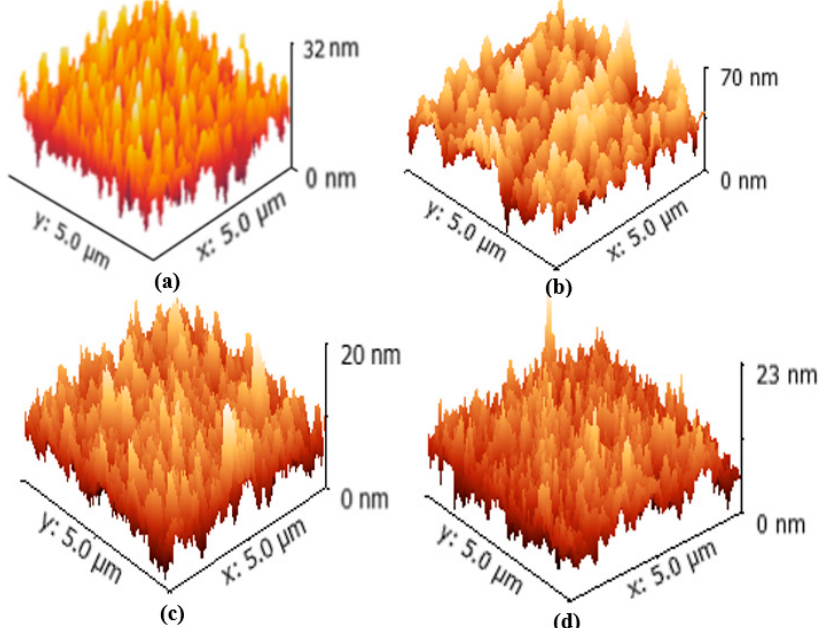
Figure 5. Two-dimensional surface morphologies of CdTe films prepared at different substrate-target